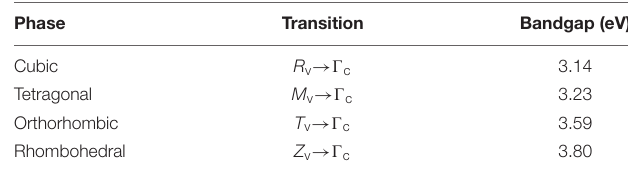
TABLE 2 | Theoretical and experimental bandgap values for KN. TABLE 3 | Fundamental bandgaps for the different phases of KN using the HSE-30 functional. [After Schmidt et al. (2017)].